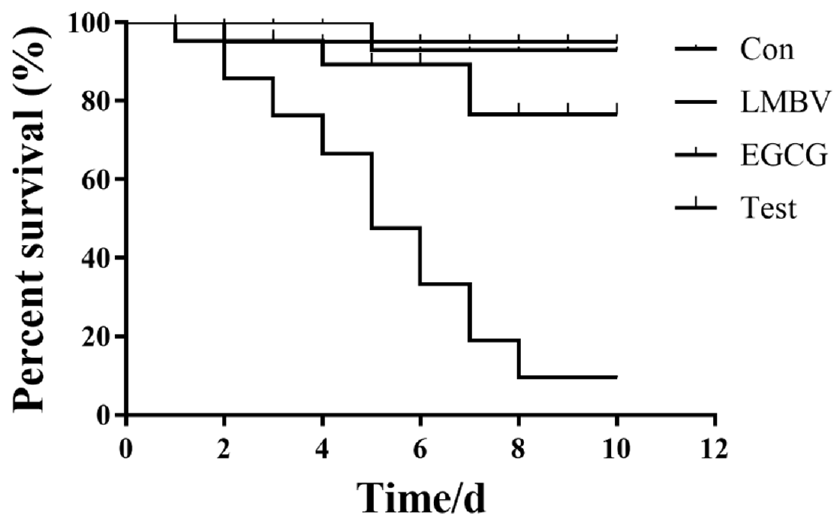
Figure 8. Cumulative mortality over 10 days. In the group of fish treated with LMBV only, the cumulative mortality reached 90% on day 8 post-infection. By contrast, in the test group, cumulative mortality was 20%. It indicated that EGCG had anti-LMBV activity in vivo.